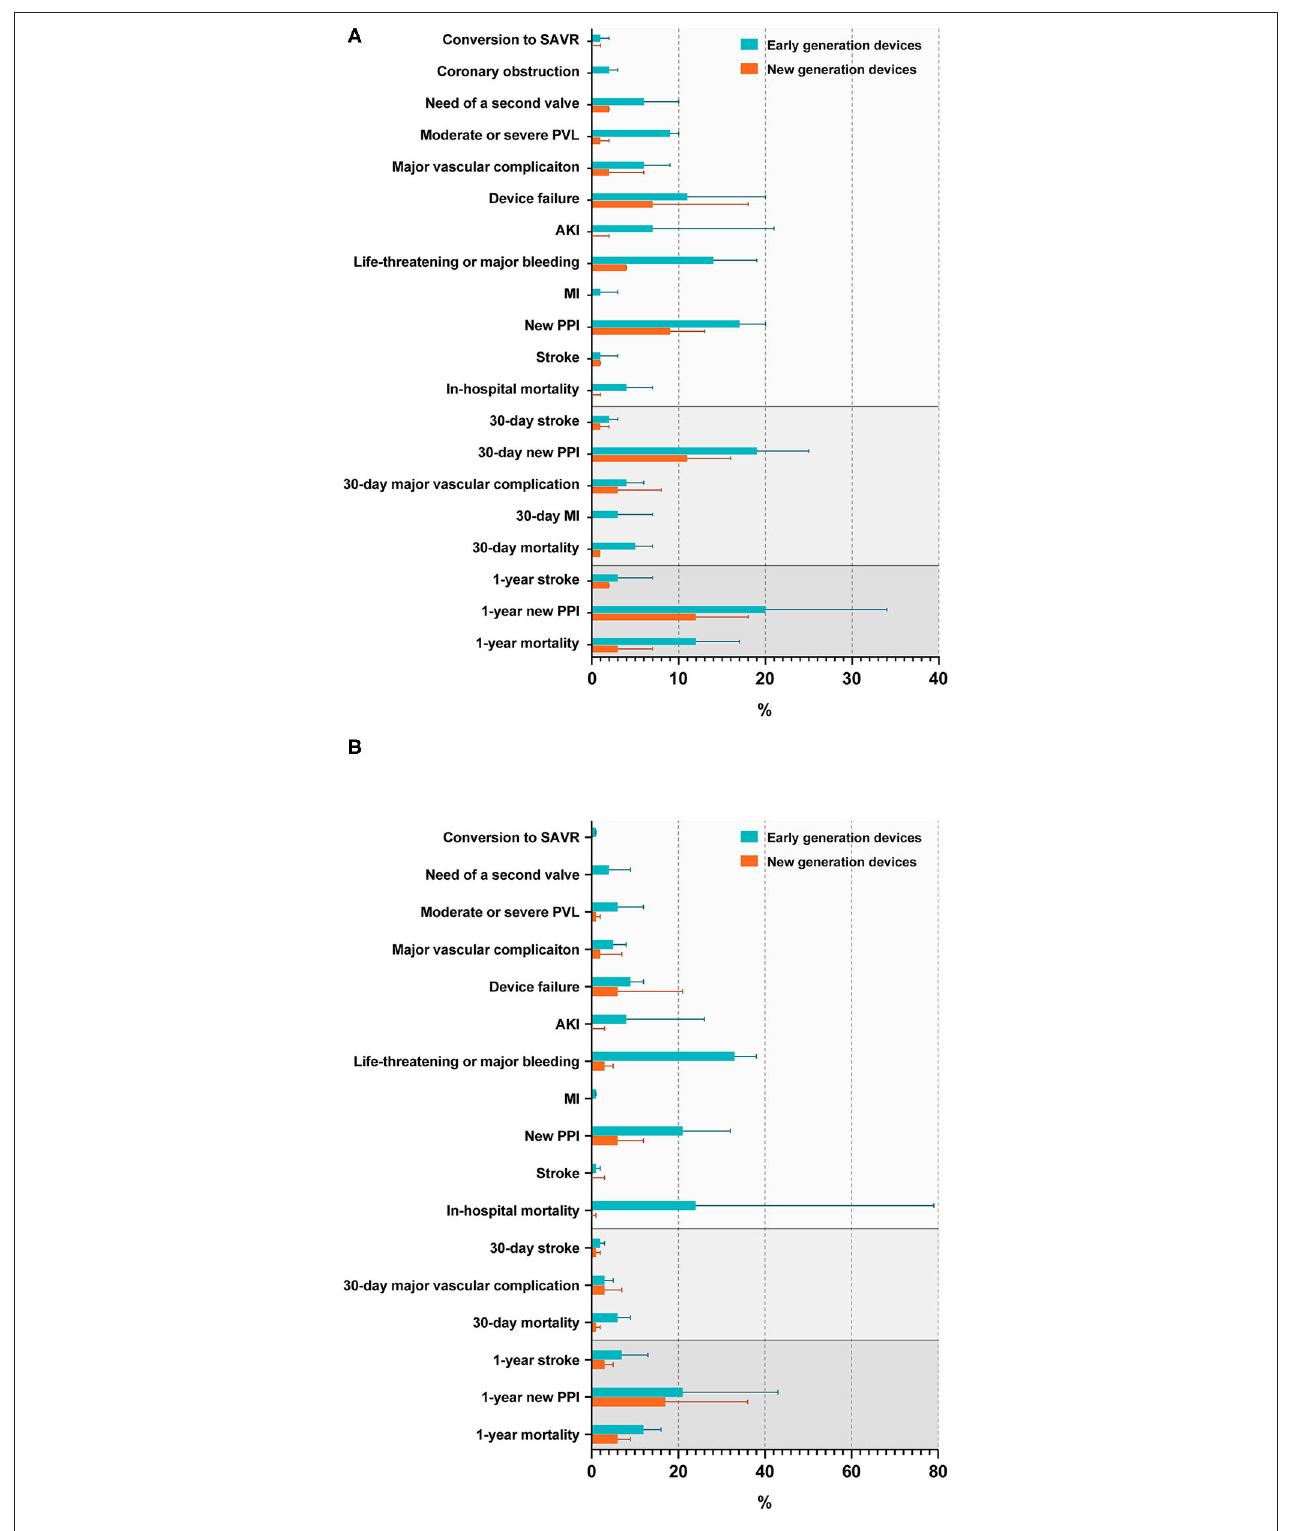
FIGURE 4 | Rates of procedural complications and outcomes in patients with BAV (A) and TAV (B) . SAVR, surgical aortic valve replacement; PVL, paravalvular leakage; AKI, acute kidney injury; MI, myocardial infarction; PPI, permanent pacemaker implantation.